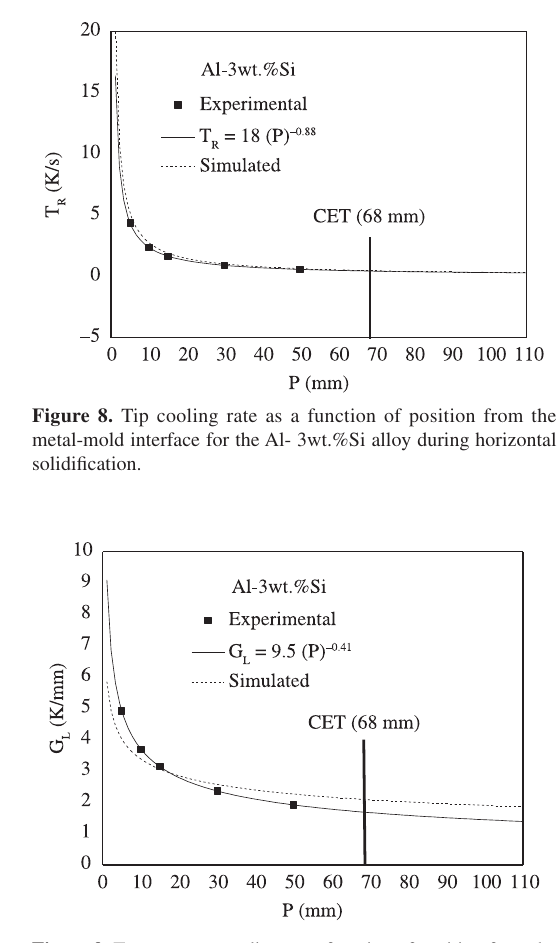
Figure 7. Tip growth rate as a function of position from the metal-mold interface for the Al- 3wt.%Si alloy during horizontal solidification.